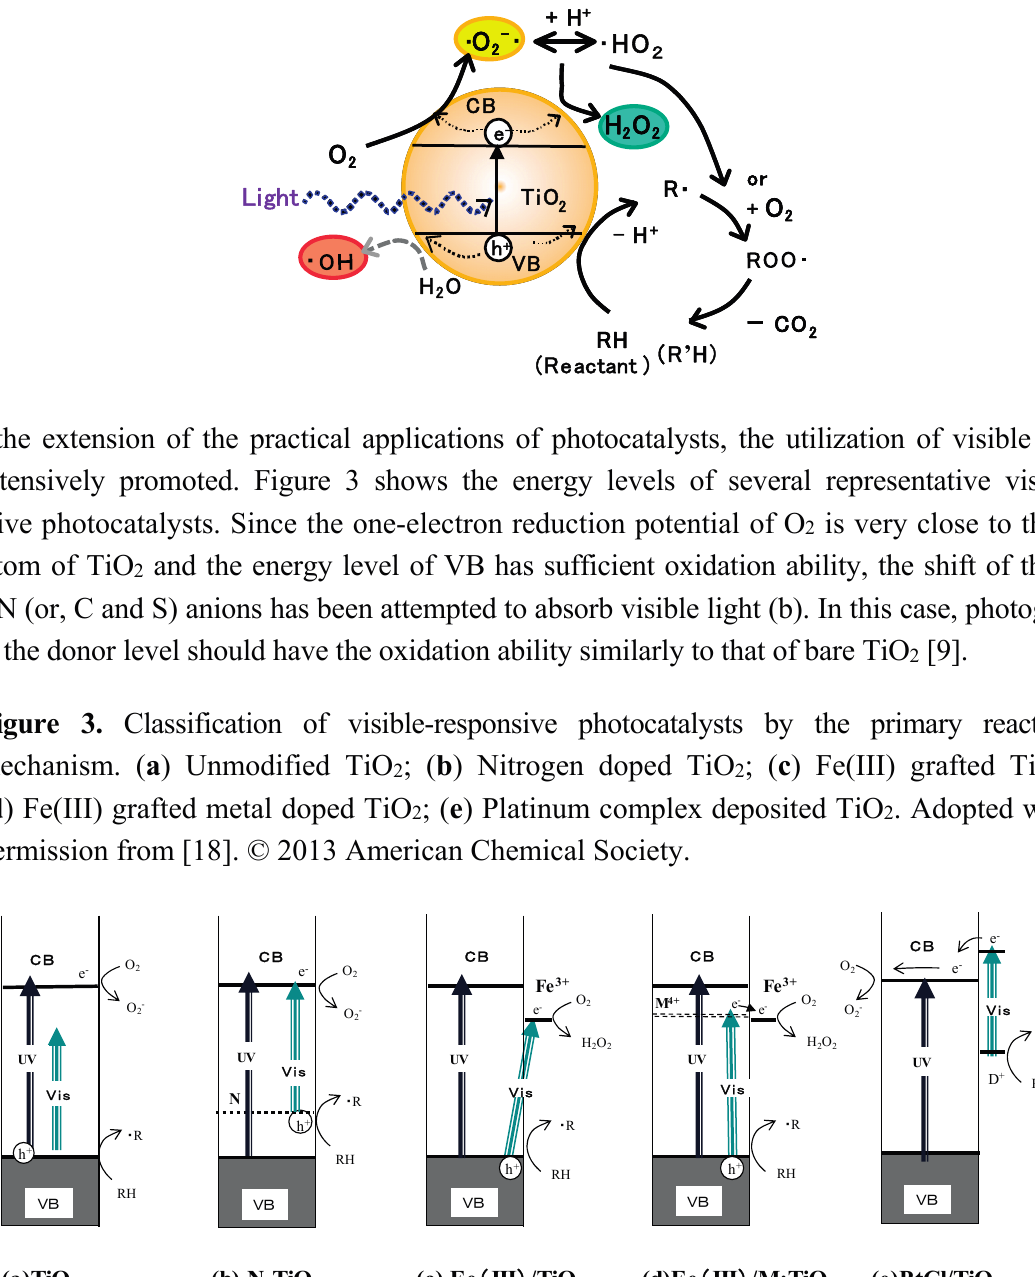
Figure 2. General reaction processes for the photocatalytic oxidation of organic molecules.